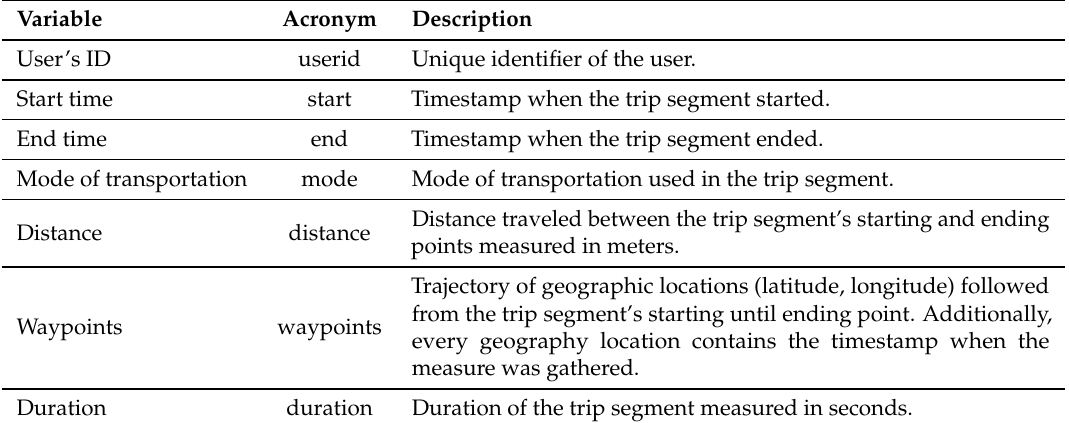
Table 1. Description of the variables.